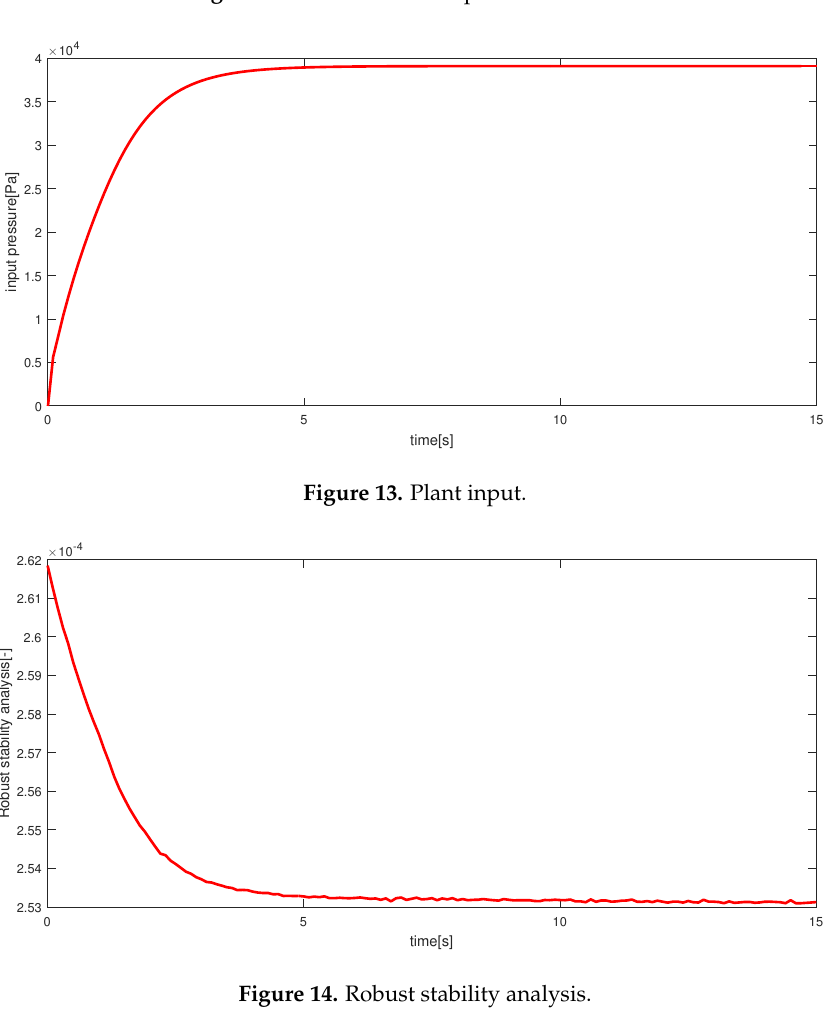
Figure 12. The result of the previous method.